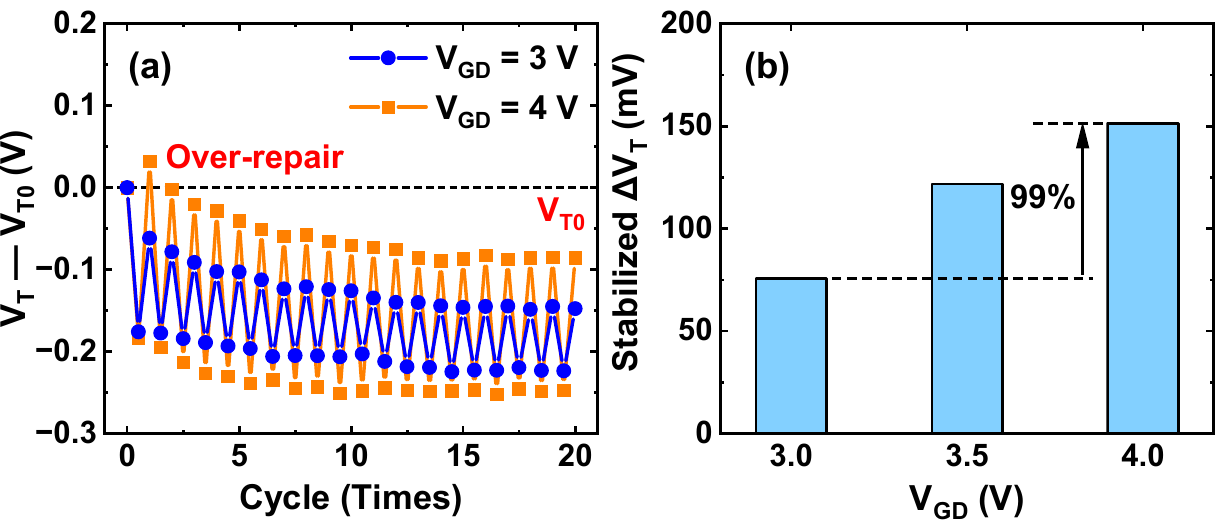
Figure 11. ( a ) Evolutions of V T variation (V T —V T0 ) during 20 cycles of HCD/GIDL at different GIDL biases. Each cycle contains 200 s HCD stress (V G,STR = V D,STR = − 2 V) followed by 1 ks GIDL repair. ( b ) Stabilized Δ V T during 20 cycles of HCD/GIDL at different GIDL biases. Fixed V D,GIDL = − 2.5 V; V G,GIDL varies from 0.5 V to 1.5 V.